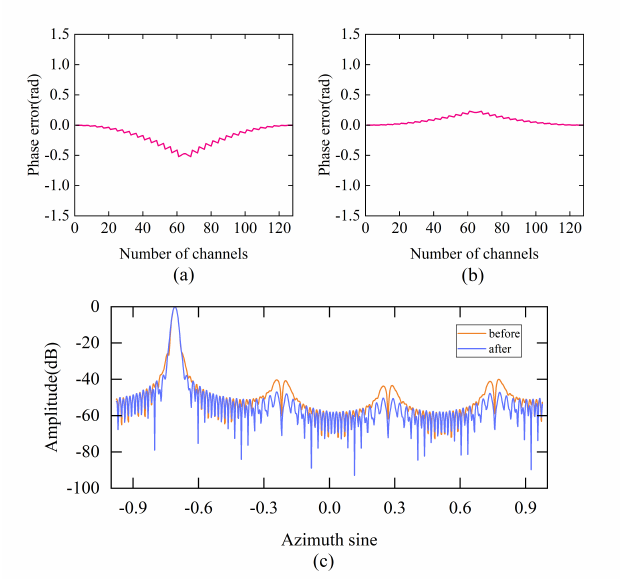
Figure 9. ( 20 m, − 45 ◦ ) Target compensation result. ( a ) Phase error before compensation. ( b ) Phase error after compensation. ( c ) Azimuthal